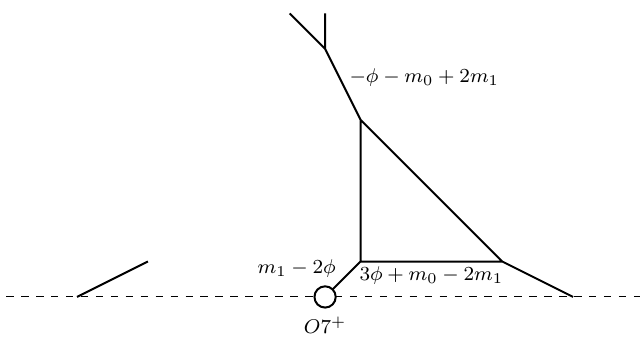
Figure 2. A 5-brane web for SU(2) π + 1 Adj , where a flop transition associated with the e curve in P 2 is